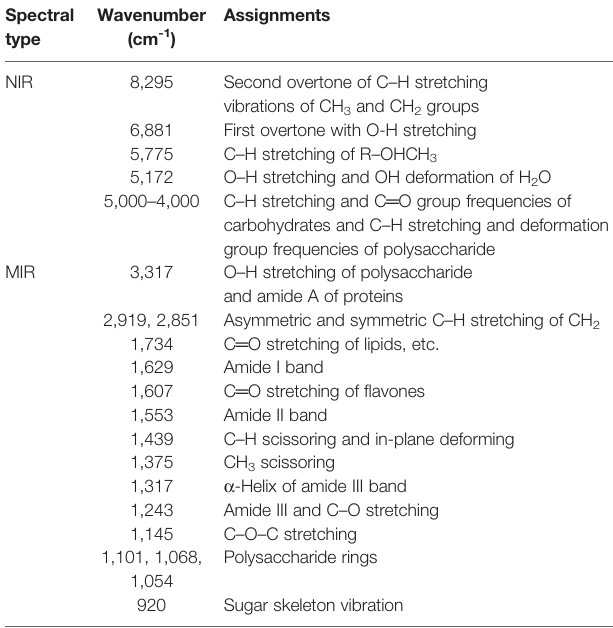
TABLE 2 | Peak assignments on the FT-NIR and ATR-FT-MIR spectra of